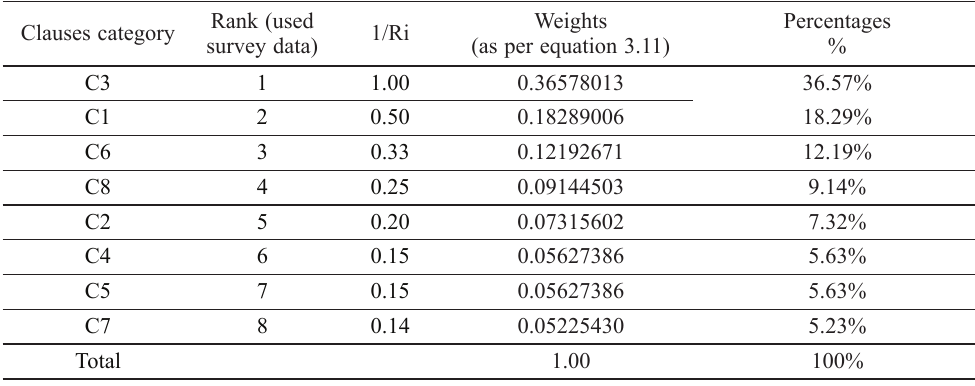
Table 8. Ranking of clause categories sorted weights in the order of their magnitudes